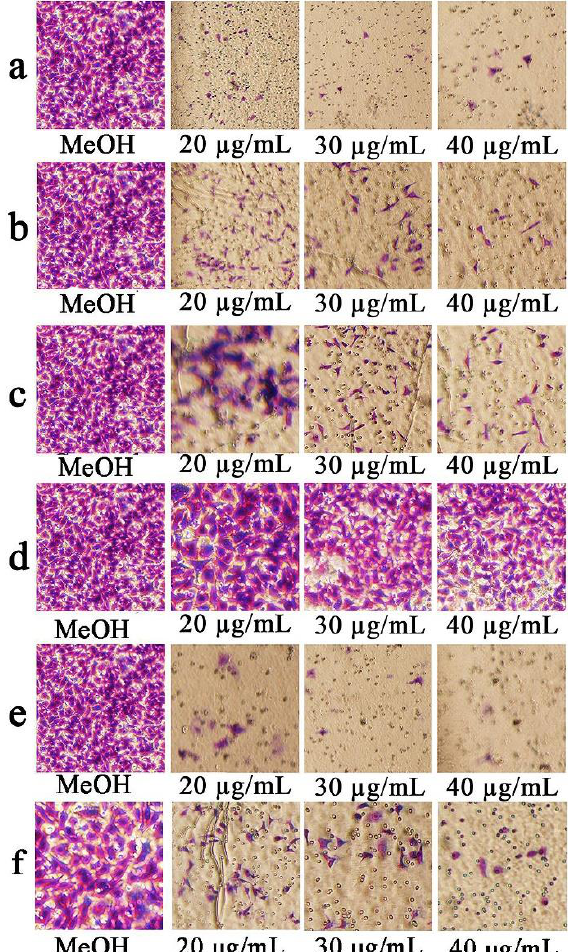
Figure 7. Cell migration assay. ( a – f ) show the effects of different concentrations (20 µg/mL, 30 µg/mL and 40 µg/mL) of compounds 1 to 5 and cisplatin on the migration of A549 cells, respectively.